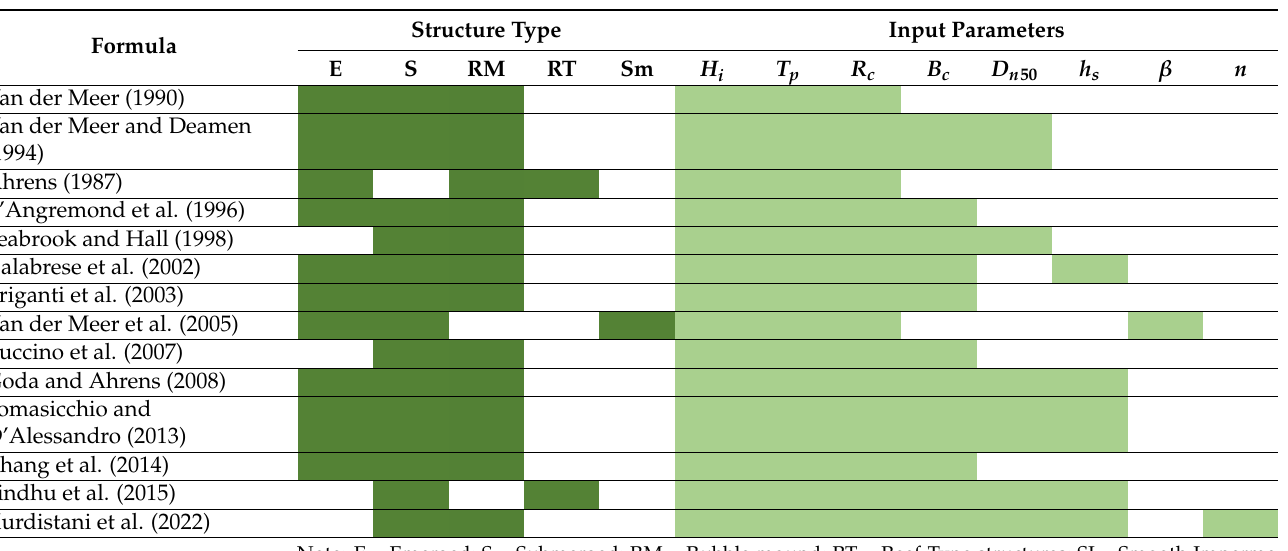
Table 2. Features of existing formulae including the type of the structures for which they have been calibrated and the considered